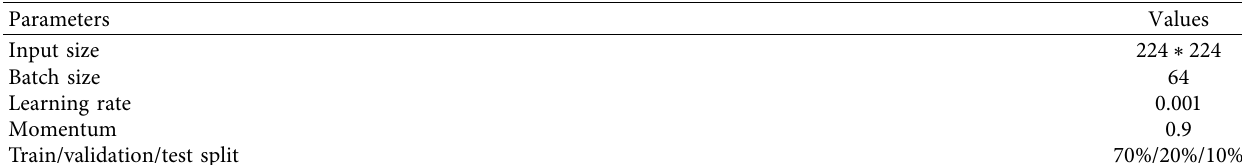
Table 1: Hyperparameters of the